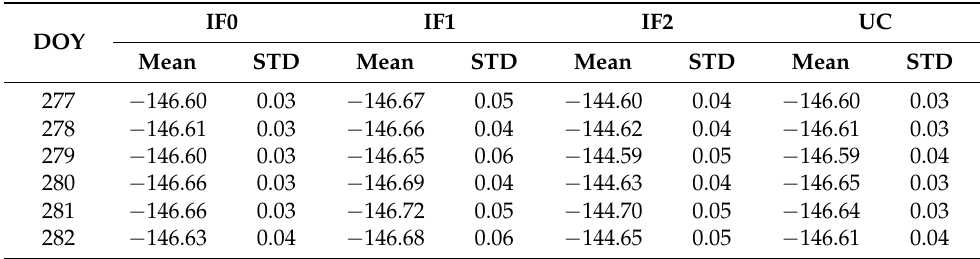
Table 6. Mean and STD values of time difference with different Galileo PPP models for PTBB- PT11 (ns).